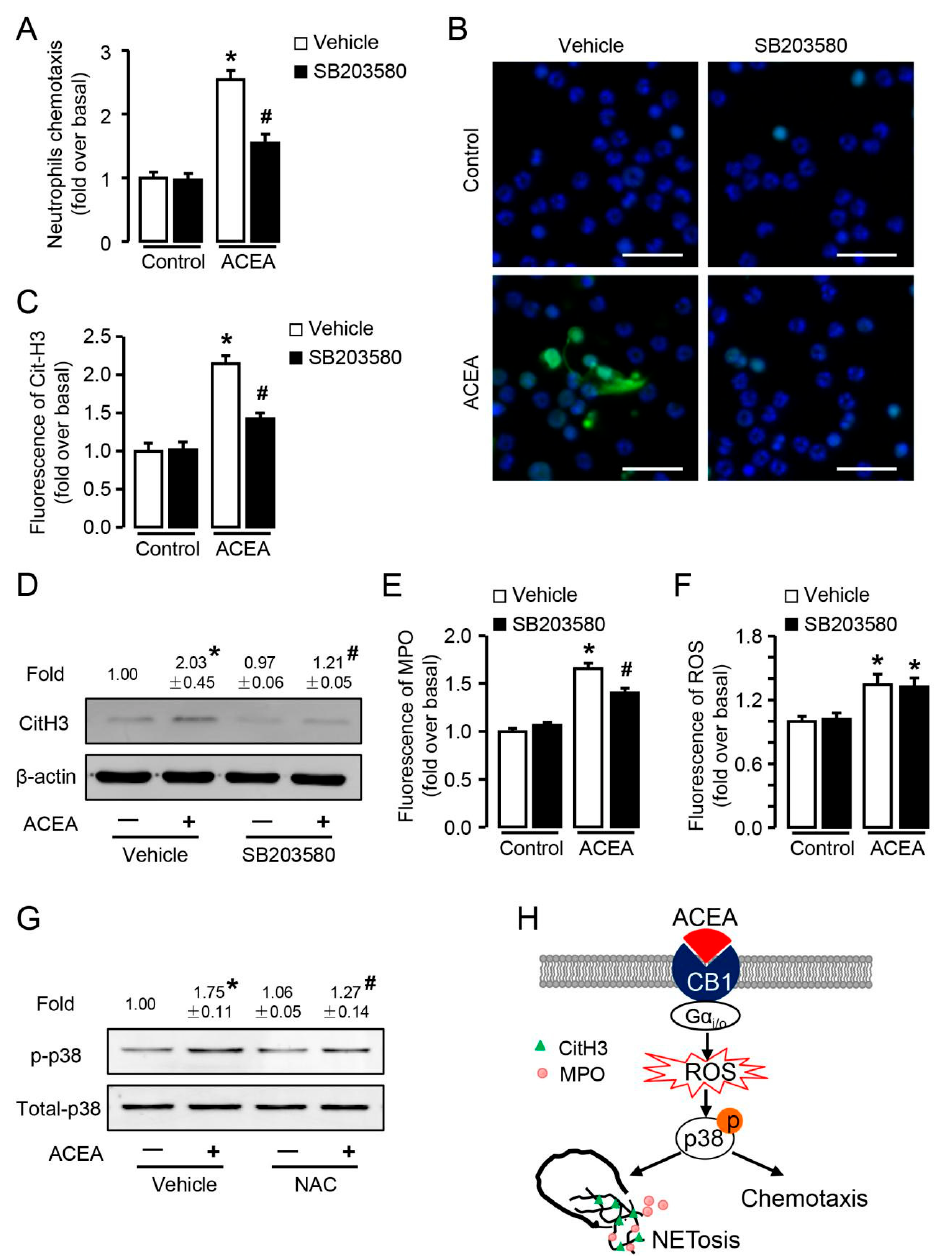
Figure 10. p38 MAPK signaling pathway is involved in CB1-mediated neutrophil chemotaxis and NETosis, and located in the downstream of ROS. ( A ) ACEA-induced neutrophil chemotaxis with or without p38 inhibitor SB203580 (10 µ M). ( B , C ) Quantification of CitH3 immunofluorescence with or without SB203580. Scale bars, 20 µ m. ( D ) CitH3 protein level with or without SB203580 was examined by Western blot. ( E ) Quantification of MPO immunofluorescence with or without SB203580. ( F ) ROS burst in ACEA-treated neutrophils with or without SB203580. ( G ) Phosphor-p38 and total p38 expression was measured by Western blot with or without NAC. ( H ) Schema graph of CB1 in neutrophil chemotaxis and NETosis. Data are presented as the mean ± SEM. N = 4 per group. * p < 0.05 vs. control. # p < 0.05 vs. ACEA-treated alone.